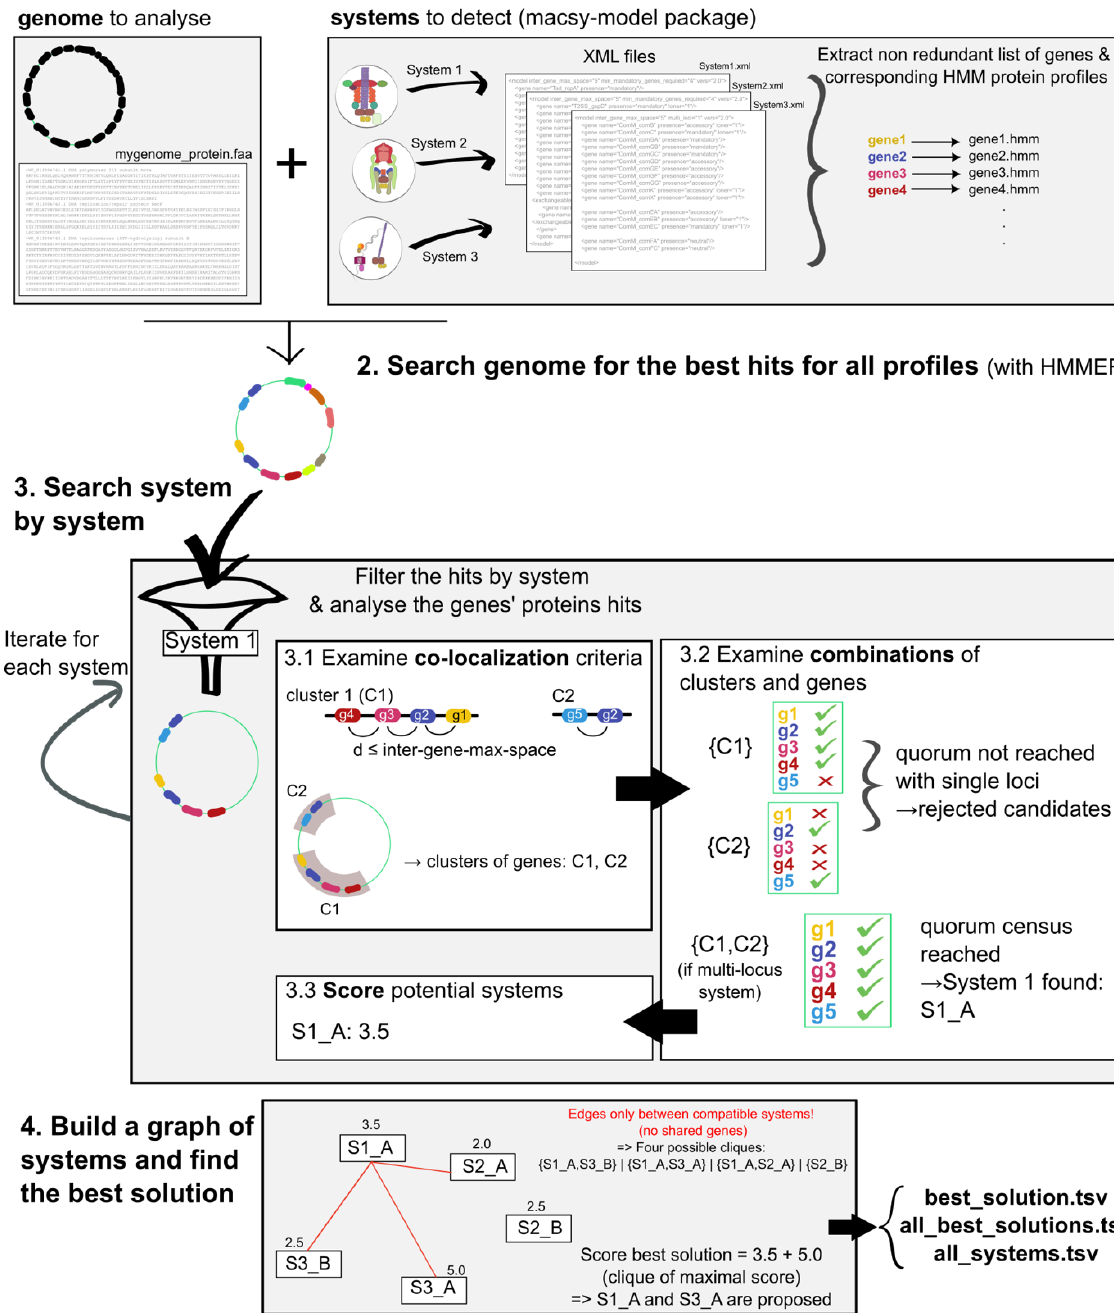
Figure 1 - Overview of the major steps of MacSyFinder v2. (1) The user gives as input the genome(s) to analyse under the form of a multi-protein FASTA file (order respecting that of the genes on genome if possible) and a macsy-model package with the systems to detect. Then the search engine establishes the non-redundant list of corresponding genes. (2) The genes are then searched with HMMER (hmmsearch using GA scores when available) using the corresponding HMM protein profiles. In the absence of GA score, the proteins with the best hits are filtered by i-evalue and profile coverage (if no GA score was available). (3) A system-by-system search is then performed. The hits corresponding to a first system are selected (“g1” as hit for gene 1), and clusters of genes are formed by gathering the hits respecting the maximal inter-gene-max-space (3.1). Genes allowed to be “out-of-clusters” are also collected (loners and multi-systems). Then the possible combinations of clusters and “out-of- clusters” genes are computed, and the program tests if they respect the quorum for the system (3.2). Finally, all candidate systems are scored (3.3). Step (3) is re-iterated for each system to be detected. Once all systems have been examined, the best solution is searched using a graph-based